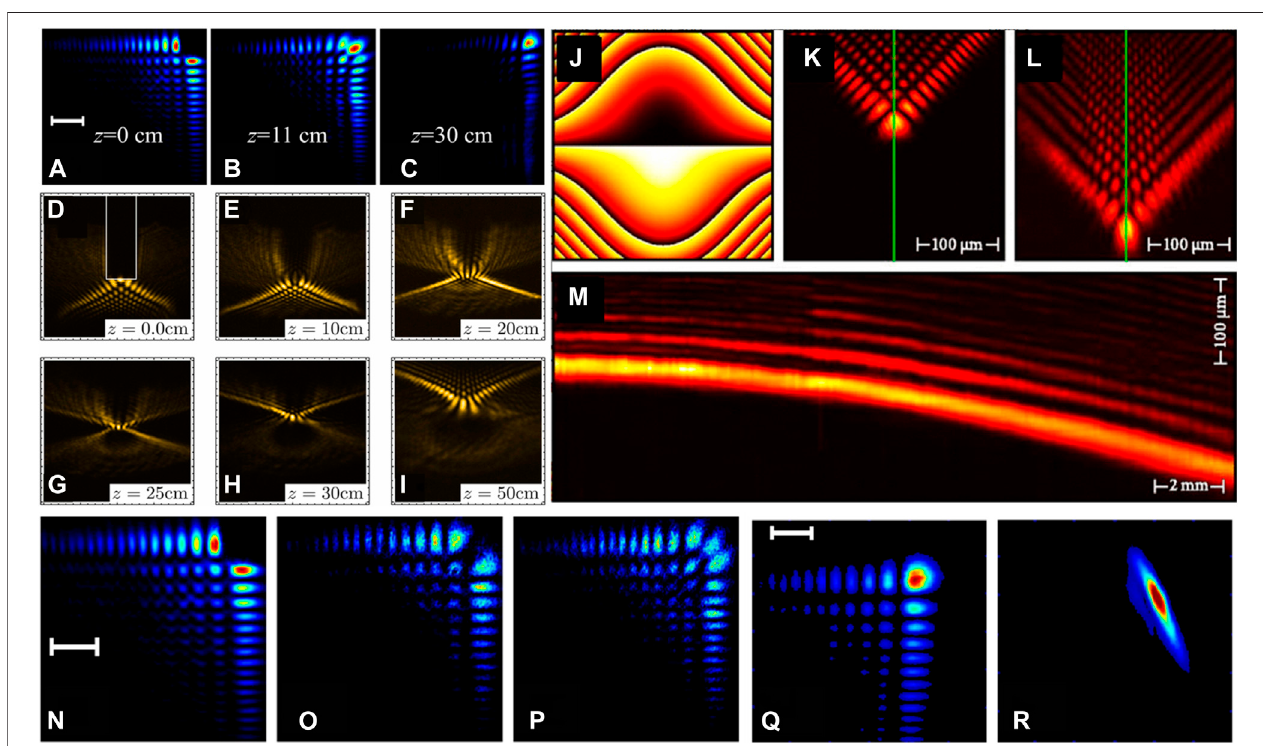
FIGURE 9 | (A – C) Self-healing feature of the Airy beam with the main lobe obstructed. Intensity patterns at (A) the input z (cid:2) 0, (B) z (cid:2) 11 cm, and (C) z (cid:2) 30 cm. (D – I) Self-healingofthePearceybeamafteranarbitraryperturbation.Theobstaclewasacylinder,withthewhitelineindicatingtherectangularprojectionin (D) . (J) Cubic phasepattern.ExperimentallyobservedtransversedistributionofAirybeamatthe (K) frontand (L) rearfacesofacrystal. (M) Transversalacceleration.Thegreenlinesin (K,L) indicate the longitudinal section in (M) . (N – P) Self-healing of an Airy beam in a scattering suspension of silica microspheres with 0.5 µm in diameter in pure water. Intensity patterns at (N) the input z (cid:2) 0, (O) z (cid:2) 5 cm, and (P) z (cid:2) 10 cm. (Q,R) Propagation in a turbulent medium of (Q) an Airy beam and (R) the Gaussian counterpart. Reproduced from OSA [32, 98]. Reprinted from [28], with the permission of AIP